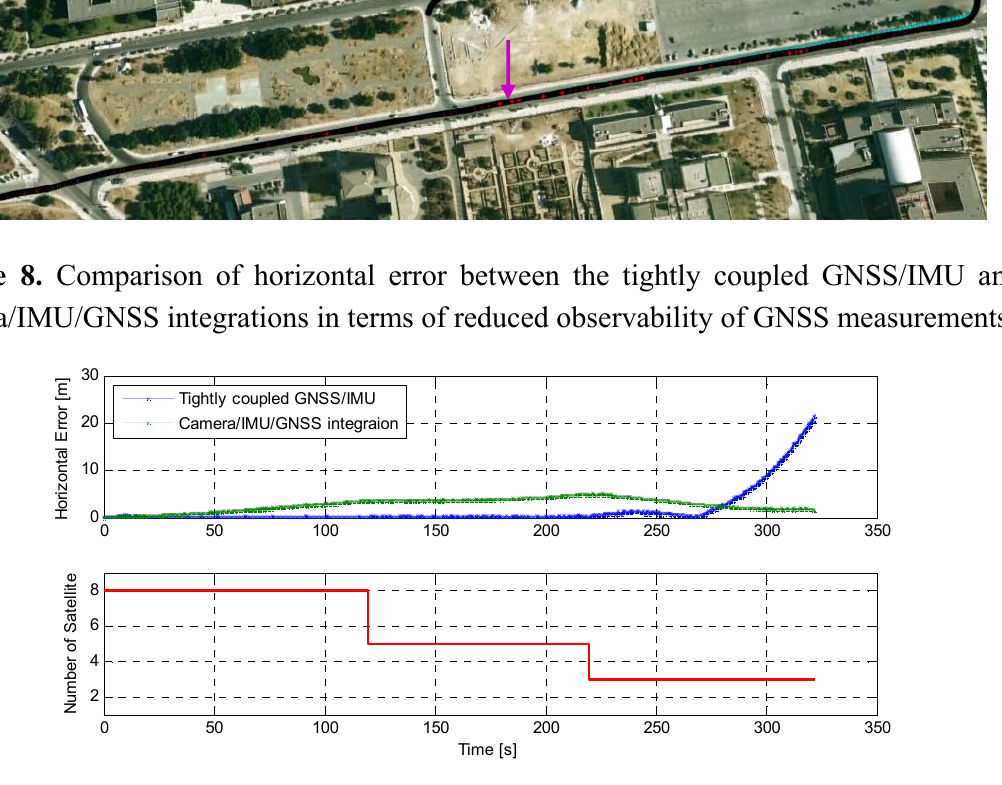
Figure 9. Horizontal positioning error statistics of the camera/IMU/GNSS